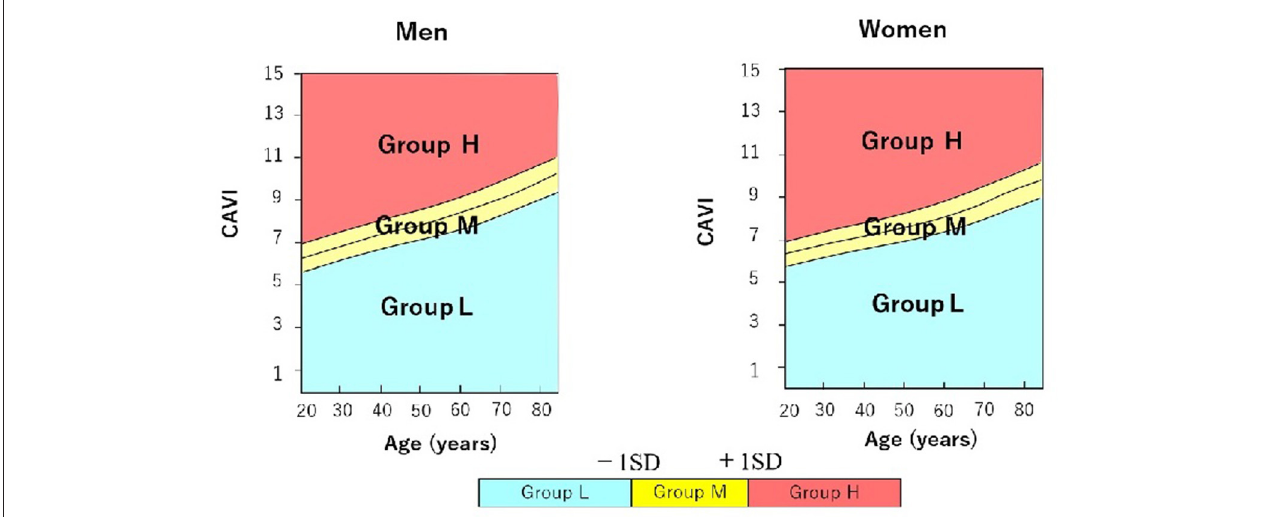
FIGURE 1 | Stratification of male and female hypertensive patients with preserved ejection fraction into 3 groups according to cardio-ankle vascular index (CAVI) value relative to mean CAVI value for age. Group L ( n = 34; 23 men, 11 women) comprised patients with low CAVI value( ≥ 1 standard deviation, SD, lower than mean for age); group M ( n = 94; 73 men, 21 women) comprised patients with medium CAVI value ( ± 1 SD of mean for age); and group H ( n = 37; 23 men, 14 women) comprised patients with high CAVI value ( ≥ 1 SD higher than mean for age). CAVI, cardio-ankle vascular index; SD, standard